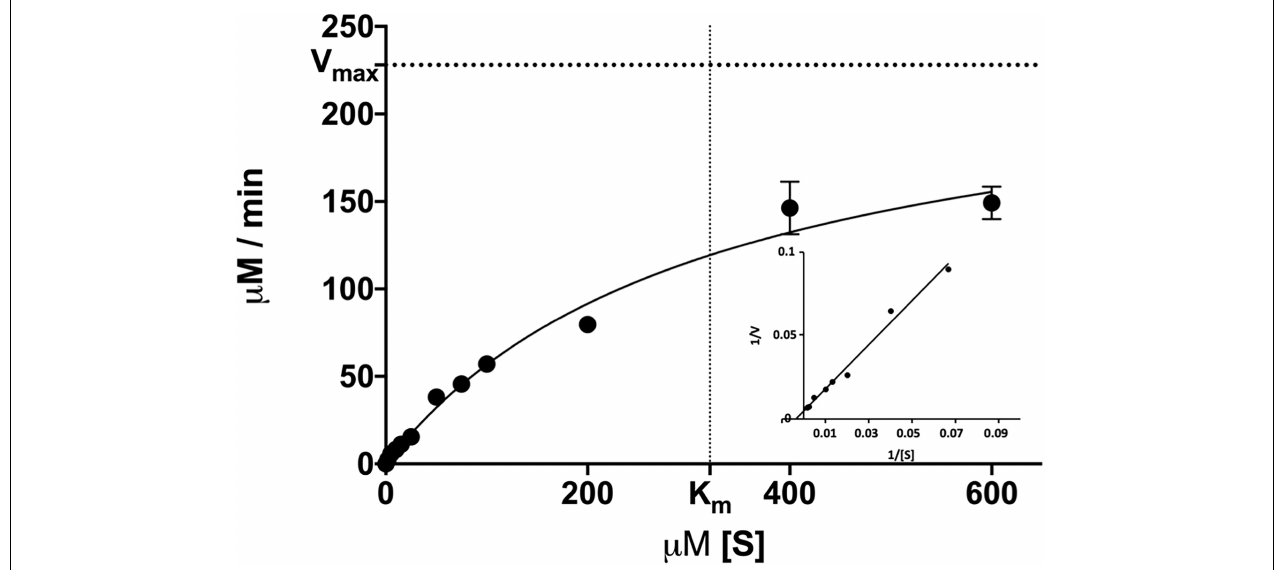
FIGURE 5 | Michaelis-Menten kinetics were determined at various substrate concentrations (2–600 µ M) of p -nitrophenyl butyrate. The V max of DS-007 was determined to be 238,86 ± 5.30 µ M/min and the K m was determined to be 321.69 ± 11.27 µ M. The k cat is 398.11 s − 1 and the k cat /K m is 1.24 × 10 6 s − 1 mol − 1 . Standard deviation from three independent experiments is